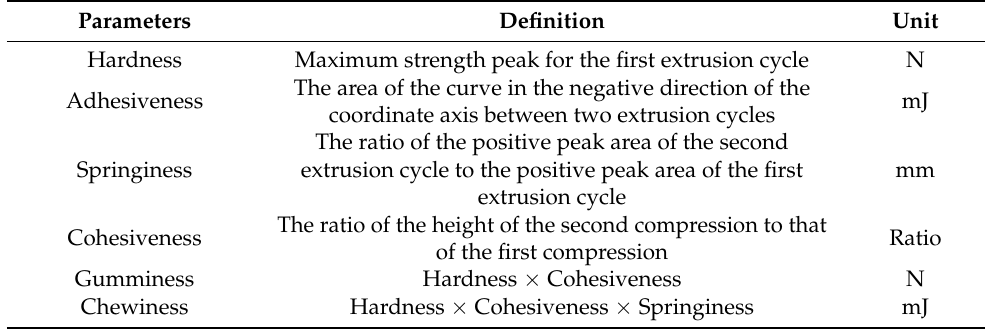
Table 1. Definition of the parameters measured by texture